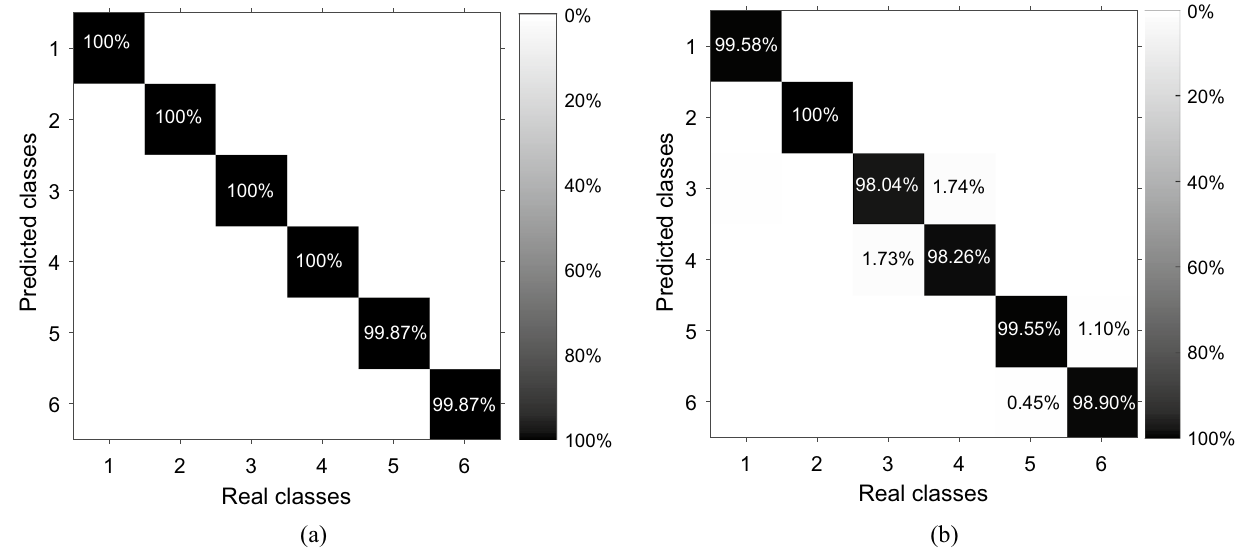
Figure 7. Results of the confusion matrices for volunteer 1 during activities. ( a ) Complete structure. ( b ) Optimized structure.